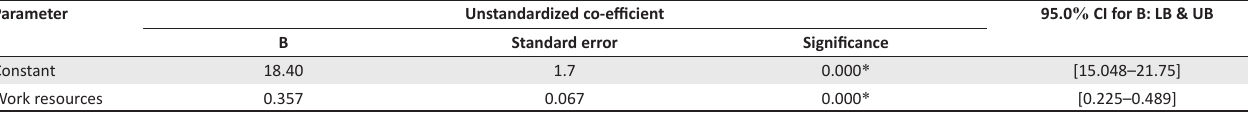
TABLE 2: Parameter estimates for work resources on employee mental health. Parameter